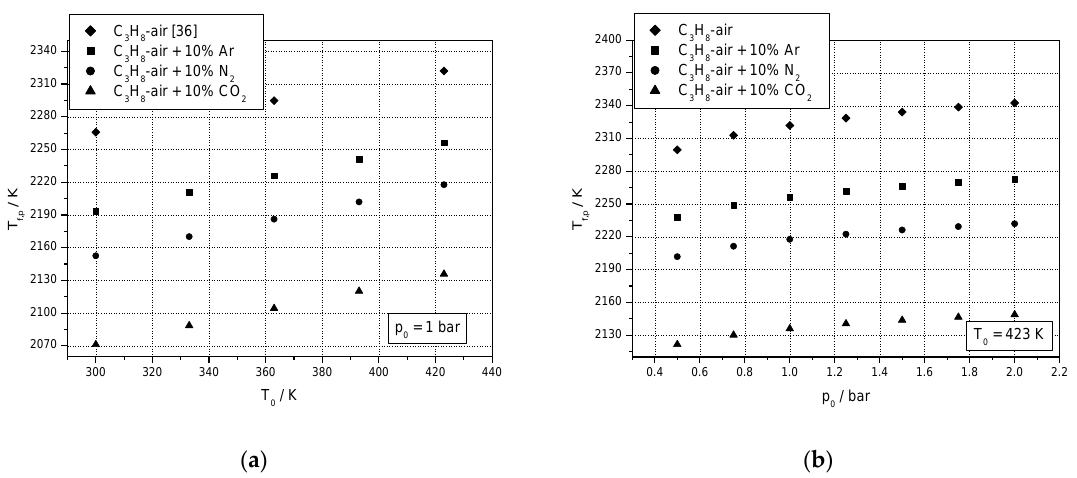
Figure 7. Adiabatic flame temperatures of isobaric combustion of stoichiometric C 3 H 8 -air+diluent mixture: ( a ) at various initial temperatures; ( b ) at various initial pressures.